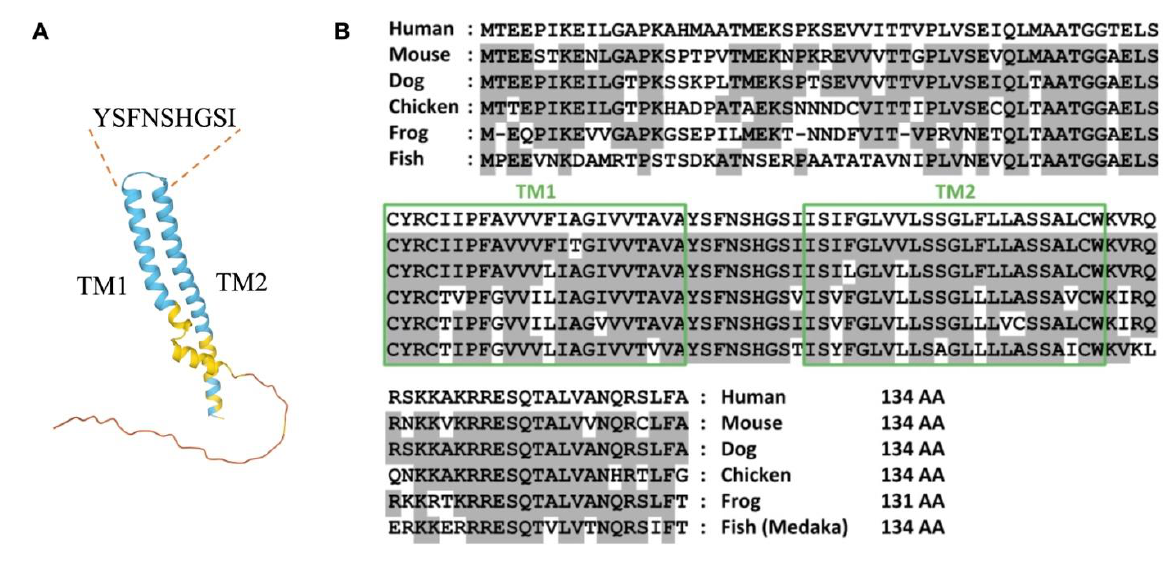
Figure 1. TMEM100. ( A ) The diagram of AlphaFold prediction of TMEM100. TM: transmembrane domain. YSFNSHGSI indicates the putative extracellular domain of TMEM100. ( B ) Amino acid sequences of TMEM100 from multiple species. Boxes represent two putative transmembrane (TM) domains. Residues conserved with the human sequence are shaded in gray. Reproduction from ref. [10]. Table 1. Summary of published Tmem100 reporter mouse